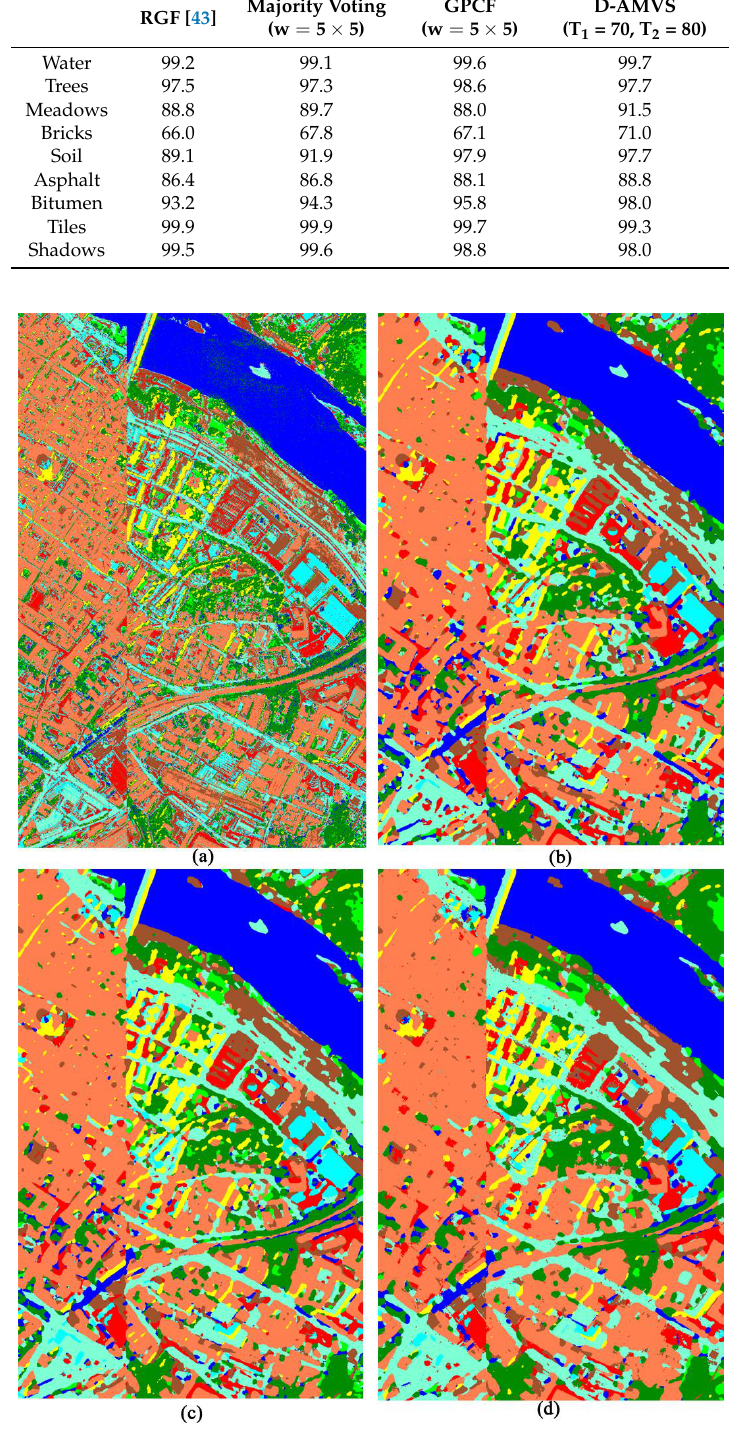
Figure 7. Comparison based on initial classified maps and different post-classification approaches for the Pavia Center image: ( a ) initial classified map based on RGV spatial–spectral method and SVM classifier, ( b ) post-classification map acquired by majority voting with a 9 × 9 window size, ( c ) post-classification map acquired by GPCF with a 9 × 9 window size, and ( d ) post-classification map acquired by the proposed D-AMVS with T 1 = 70 and T 2 =